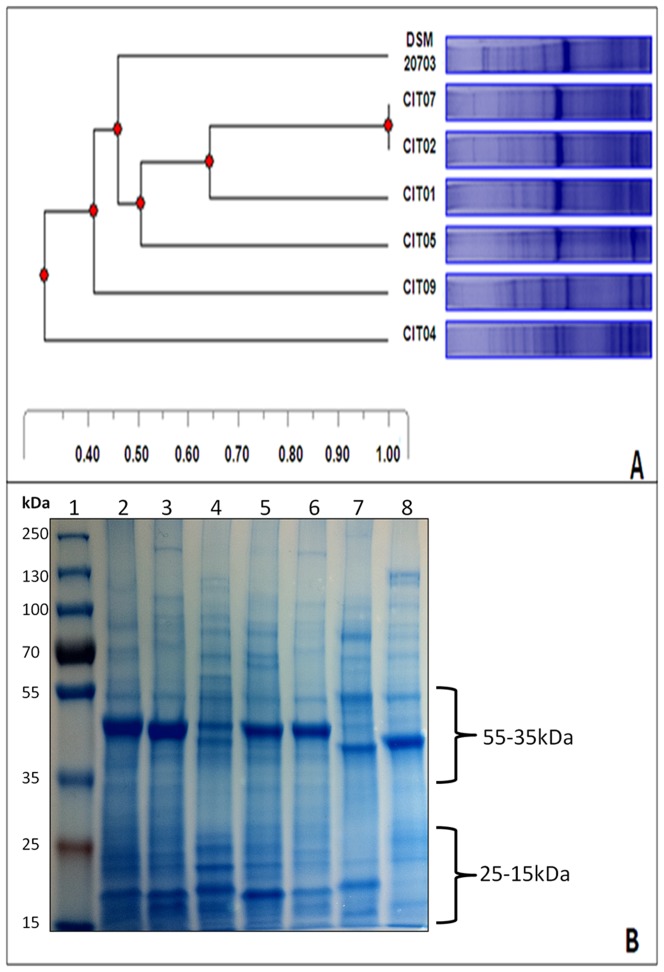
SDS-PAGE of C.
ureolyticus Soluble Proteins.(A) Protein profiles of 7 Campylobacter ureolyticus strains. Phoretix 1D pro was employed to cluster the lanes based on banding patterns. The Dendrogram is an Unweighted Pair Group Method with Arithmetic Mean (UPGMA) Dice coefficient distance tree. (B) Original SDS-PAGE gel, with variable regions highlighted. Lane 1: Page Ruler Plus Ladder, lane 2: CIT001, lane 3: CIT002, lane 4: CIT004, lane 5: CIT 005, lane 6: CIT007, lane 7: CIT009, lane 8: DSM 20703.